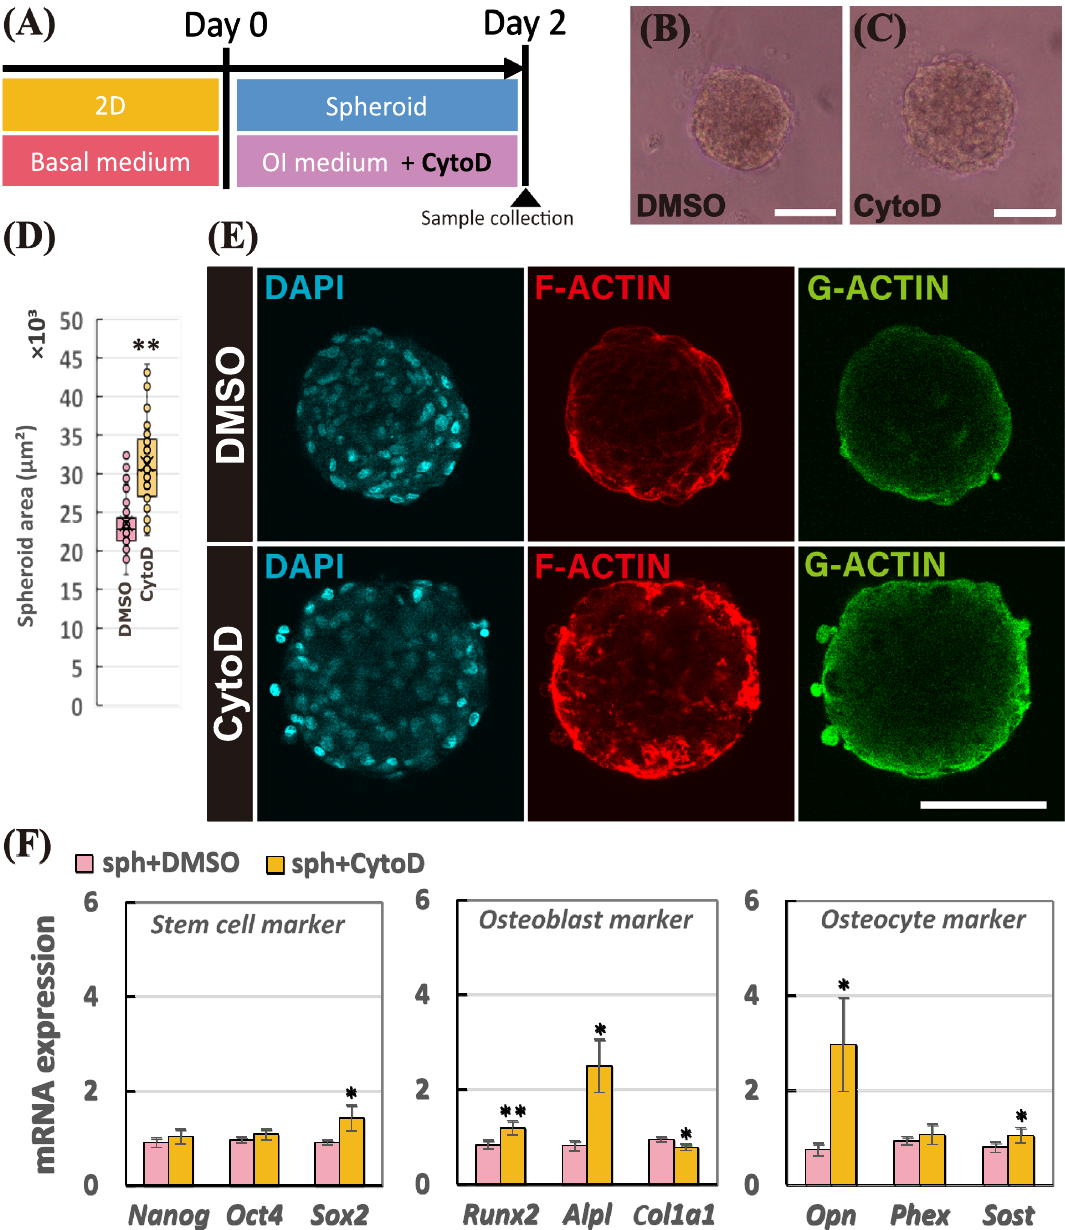
Figure 5. ( A ) Schematic of the experimental time line to fabricate the spheroid treated with 1 μM of cytochalasin D (CytoD). Morphology of the spheroids treated with ( B) DMSO and ( C ) CytoD. The scale bar represents 100 μm. ( D ) Mean values of projected area of the spheroids treated with DMSO and CytoD incubated for 2 days. ( E ) Staining images of spheroid after 2-day incubation; cell nuclei (DAPI in cyan), fibrous actin (F-actin in red), and globular actin (G-actin in green). The scale bar represents 100 μm. ( F ) Relative mRNA expressions of stem cell markers ( Nanog , Oct4 , and Sox2 ), osteoblast markers ( Runx2 , Alpl , and Col1a1 ), and osteocyte markers ( Opn , Phex , and Sost ) in the spheroid treated with DMSO and CytoD were measured by real- time PCR. All the mRNA expressions were normalized to Gapdh expressions while the results were expressed as relative amounts against the expression of spheroid samples treated with DMSO ( n = 9). The bars represent the mean ± standard error. P -value was calculated from Student’s t -test; * p < 0.05, ** p <